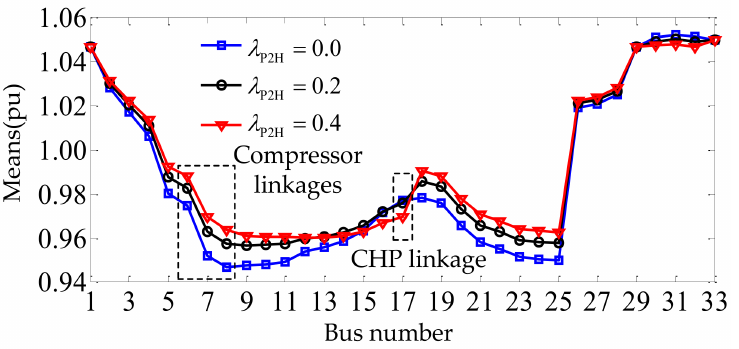
Figure 13. Mean values of voltage